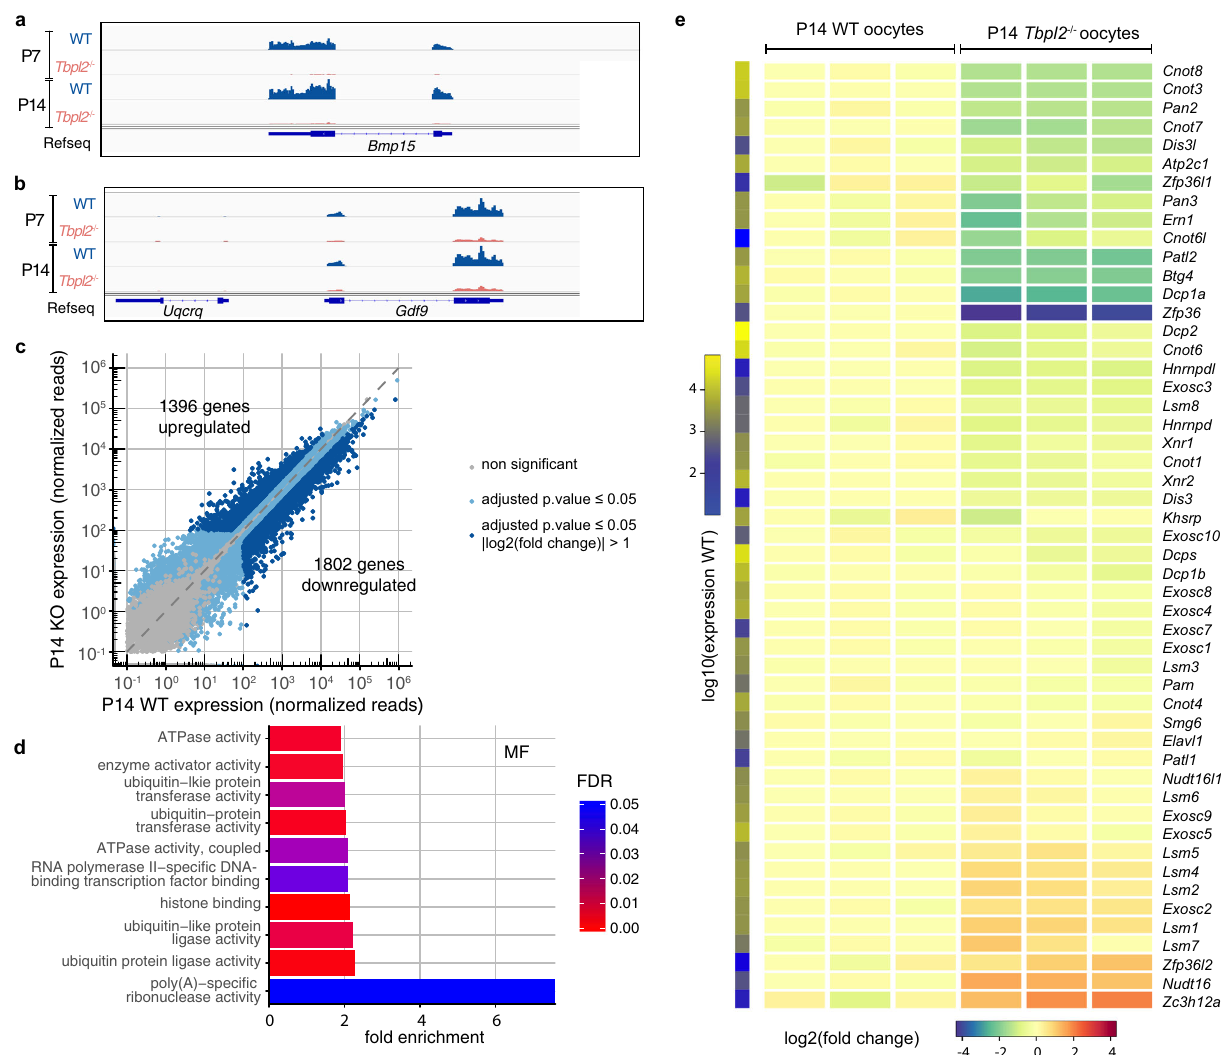
Fig. 3 Expression of genes related to the mRNA deadenylation/decapping/decay pathways in growing Tbpl2 − / − mutant oocytes. a , b Normalised Integrative Genomic Viewer (IGV) snapshots of Bmp15 ( a ) and Gdf9 ( b ) loci. Exons and introns are indicated. c Expression comparison between wild-type (WT) and Tbpl2 − / − mutant postnatal day 14 (P14) oocytes (biological triplicates). Expression was normalised to the median size of the transcripts in kb. Grey dots correspond to non-signi fi cant genes and genes with high Cook ’ s distance, light-blue dots to signi fi cant genes for an adjusted P value ≤ 0.05 and dark-blue dots to signi fi cant genes for an adjusted P value ≤ 0.05 and an absolute log2 fold change > 1, after two-sided Wald test and Benjamini – Hochberg correction for multiple comparisons. The number of up- or downregulated genes is indicated on the graph. d Downregulated genes GO category analyses for the molecular functions (MF). The top ten most enriched signi fi cant GO categories for a FDR ≤ 0.05 are represented. e Heatmap of selected genes involved in mRNA decay, decapping or deadenylation pathways. Expression levels in fold change (compared to the mean of WT) of three biological replicates of P14 WT and P14 Tbpl2 − / − mutant oocytes are indicated. The fold change colour legend is indicated at the bottom. The fi rst column on the left corresponds to the log10 of expression, scale on the